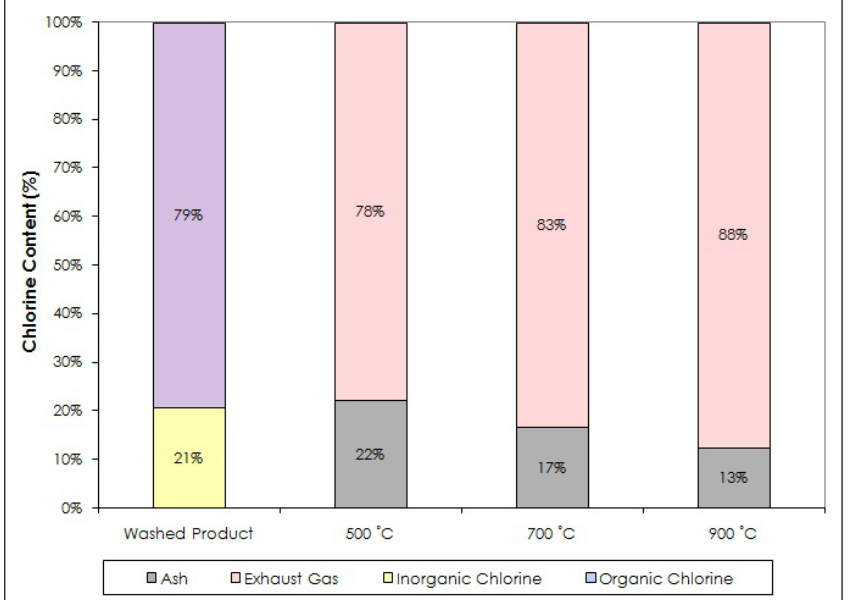
Figure 7. Chlorine contents after combustion of Washed Product with different combustion